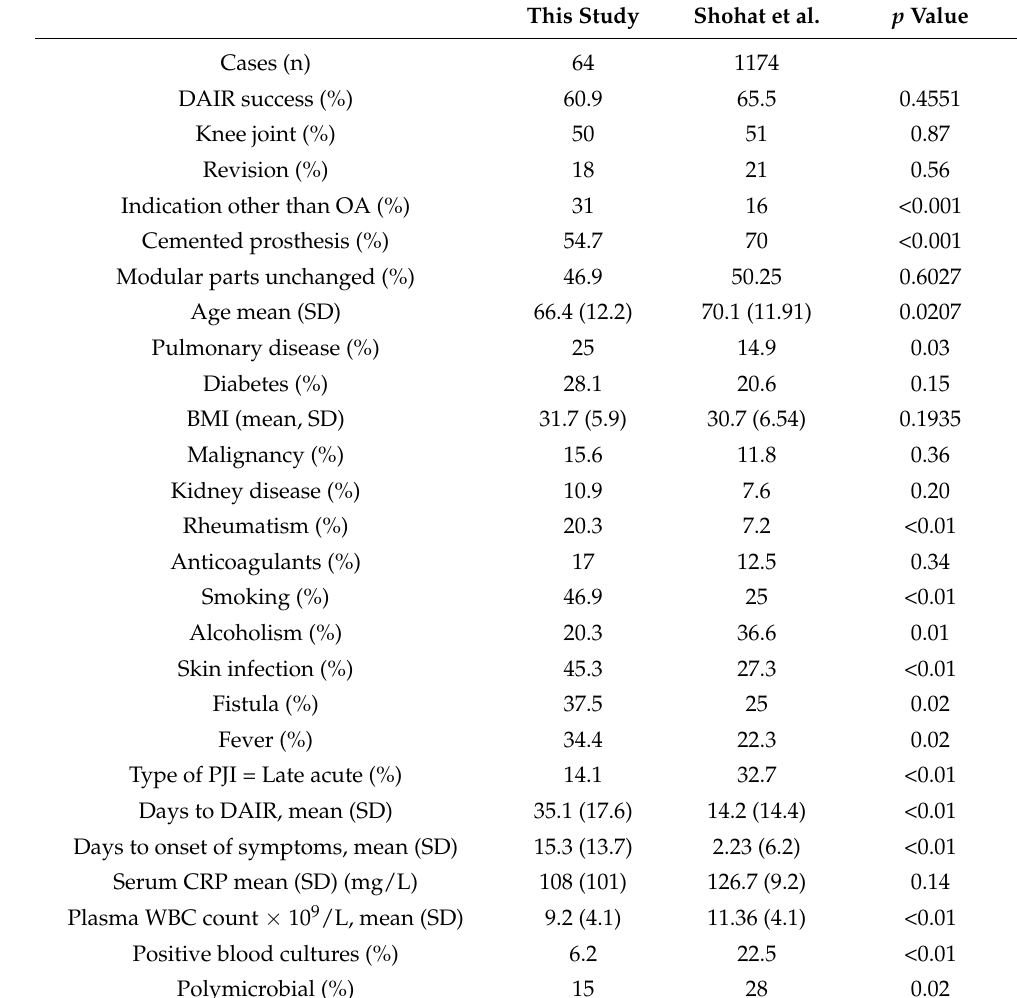
Table 2. Comparison between cohorts.